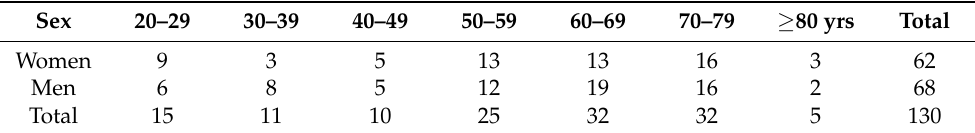
Table 1. An overview of the number of participants divided into in ten-year age ranges.